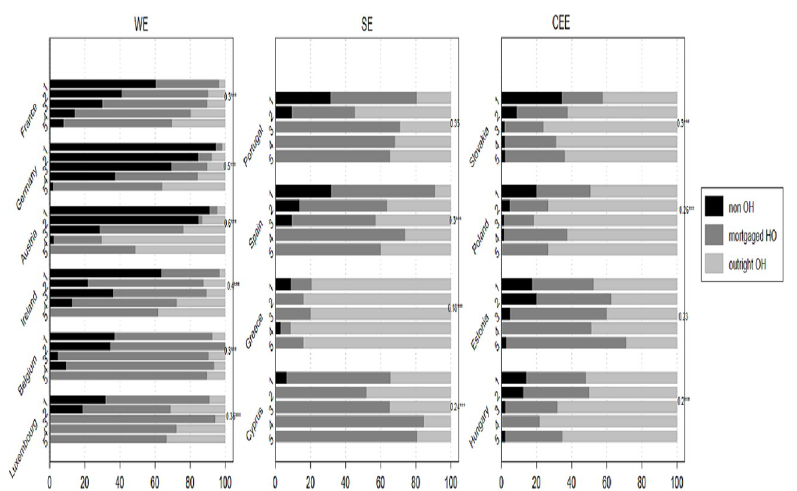
Fig 2. Housing tenure categories by quintiles of the amount of IWT and